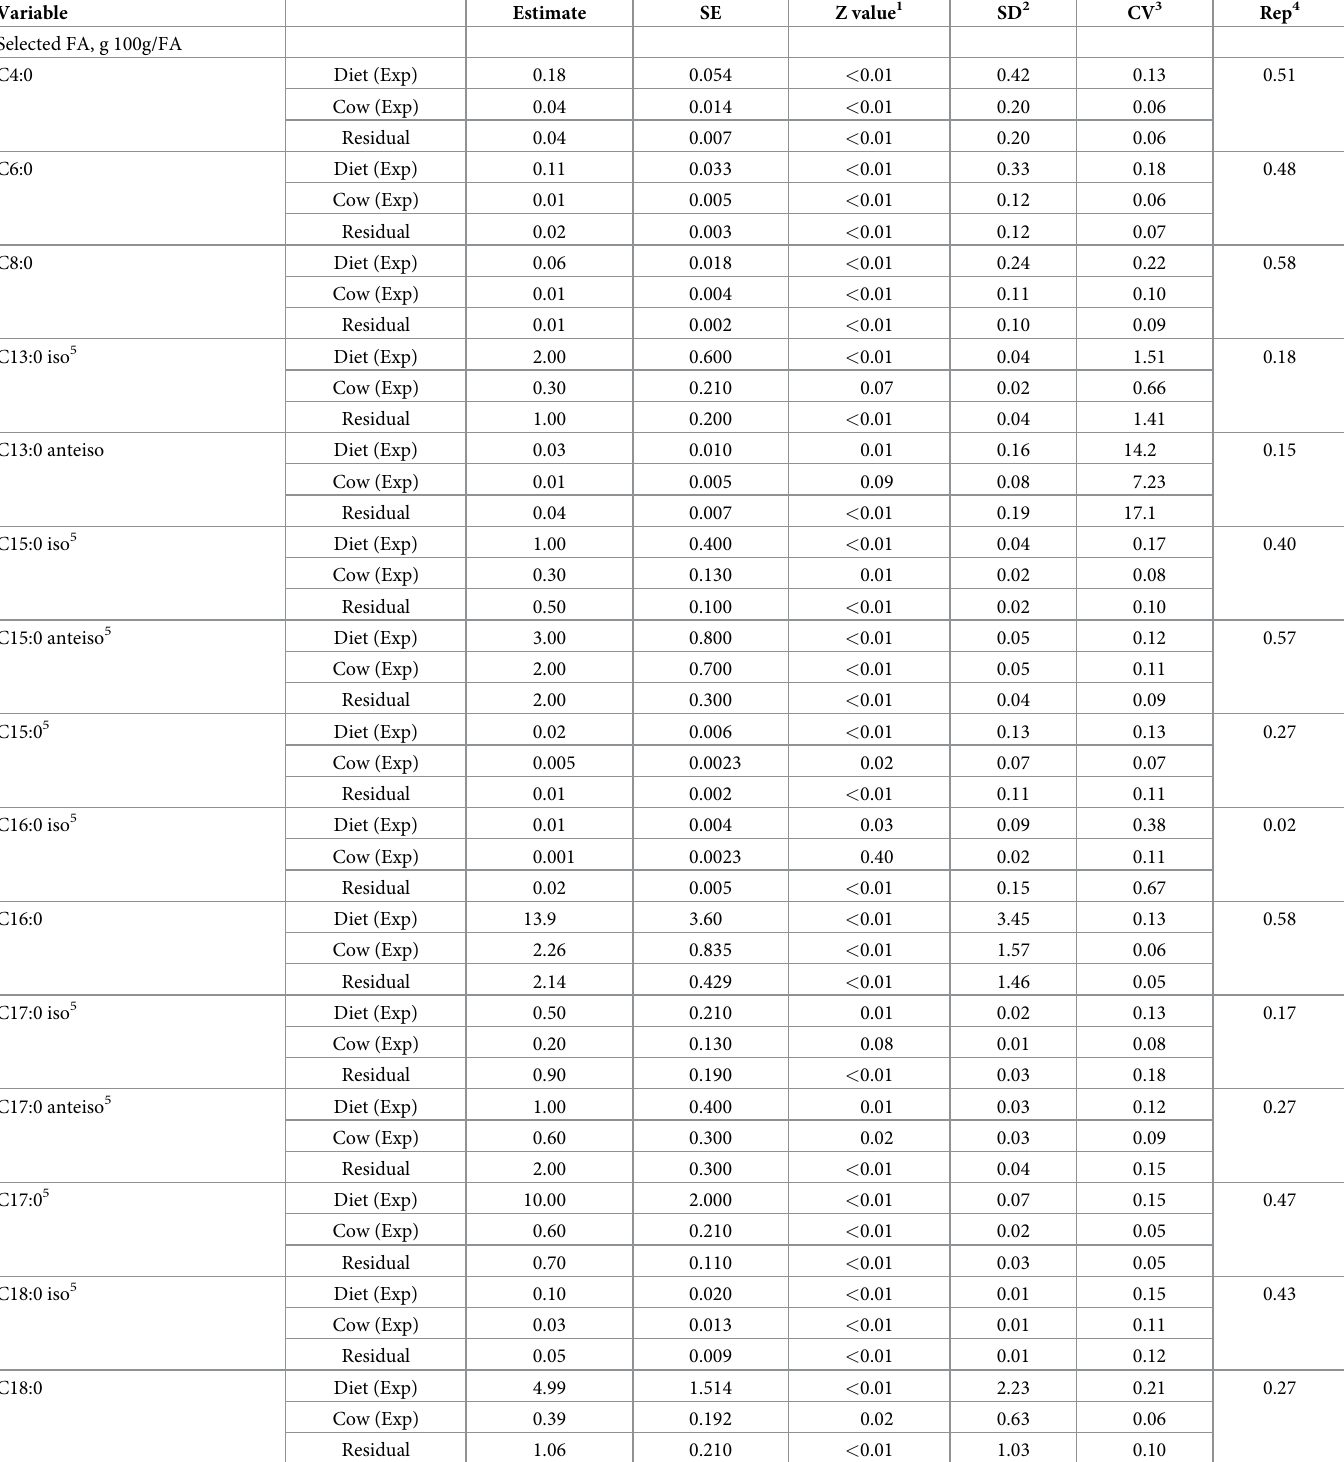
Table 6. Variance component estimates of milk fatty acids (FA) in dairy cows.